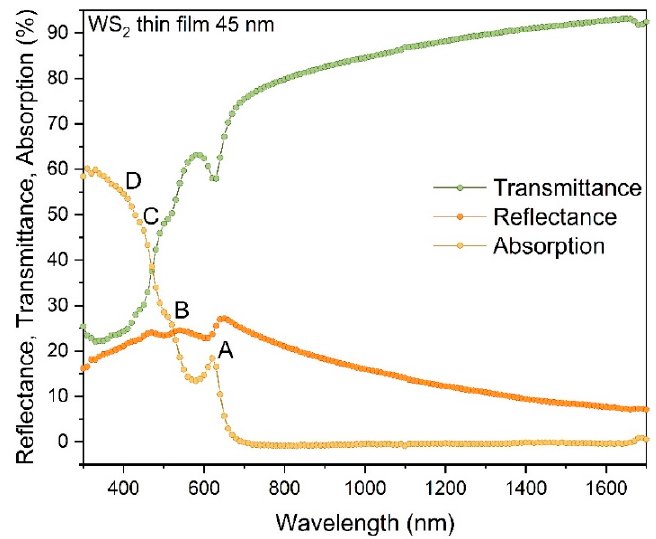
Figure 4. Optical characteristic of WS 2 thin film: absorption (A), reflectance (R), transmittance (T).